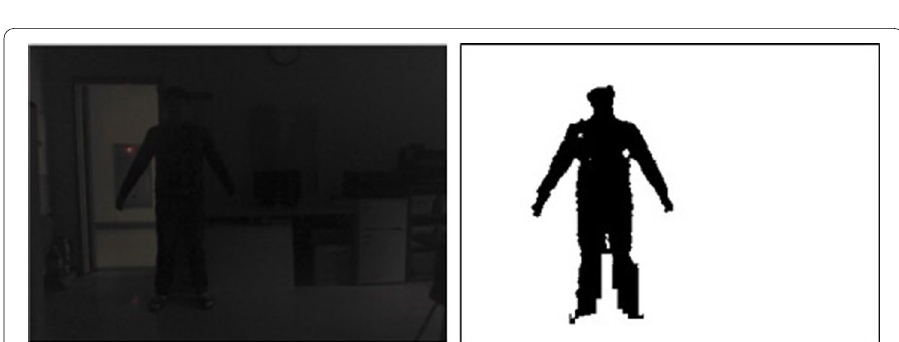
Fig. 8 Object detection result using depth camera in